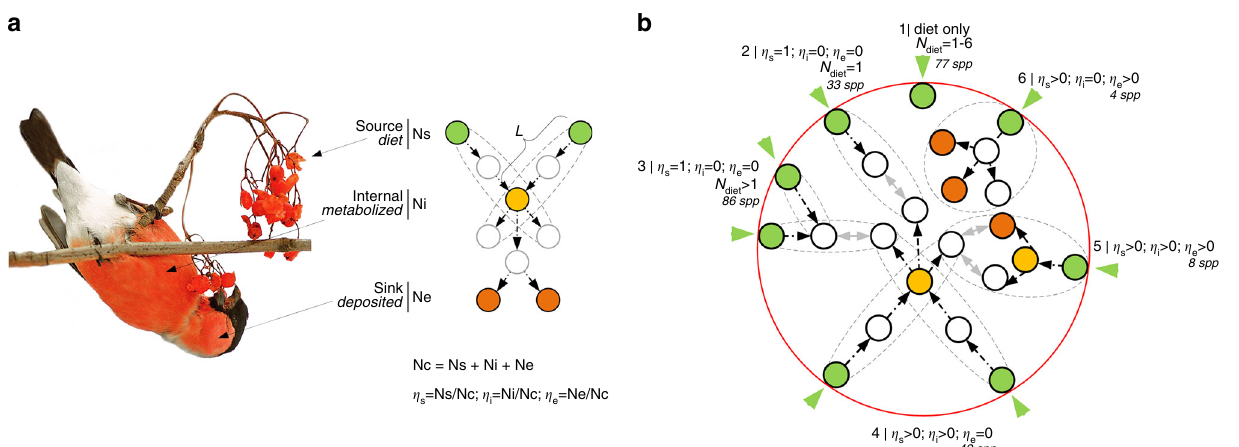
Fig. 1 Functional correspondence of controlling structures in avian carotenoid networks. a Control nodes classi fi ed into source (Ns), internal (Ni), and sink (Ne) controls based on the asymmetry of their incoming and outgoing reactions (arrows) correspond to dietary carotenoids (green circles), metabolized carotenoids (yellow), and terminal branching leading to plumage-bound carotenoids (red), respectively (see Methods section). Dashed lines outline parts of biochemical modules linking dietary and derived compounds, L is the length of path (in reactions) before a pathway starting from one dietary carotenoid merges with a pathway starting from a different dietary carotenoid at the degenerate node (yellow). A minimum number of controls (Nc) required to fully control a network is the sum of the number of source, internal and peripheral controls. Proportion of Nc due to sources ( η s ), internal branching ( η i ), and peripheral sinks ( η e ) is the control pro fi le of a network 29 . b Networks of study species, schematically grouped by their control pro fi les. Green triangles are dietary inputs, gray double-headed arrows mapped on the combined avian enzymatic network of carotenoids (enclosing red circle) illustrate potential transitions between control categories. Species in category 1 deposit only dietary carotenoids into their plumage. Networks in categories 2 and 3 are fully controlled by sources ( η s = 1). In categories 4 and 6 full control of networks requires one additional control due to either internal ( η i > 0) or sink ( η e > 0) controls, correspondingly. The networks in category 5 require all three types of